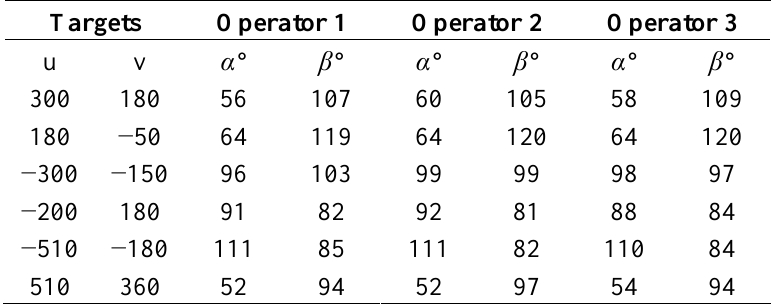
Table 4. Joint angles of robot manipulator for six target points from three